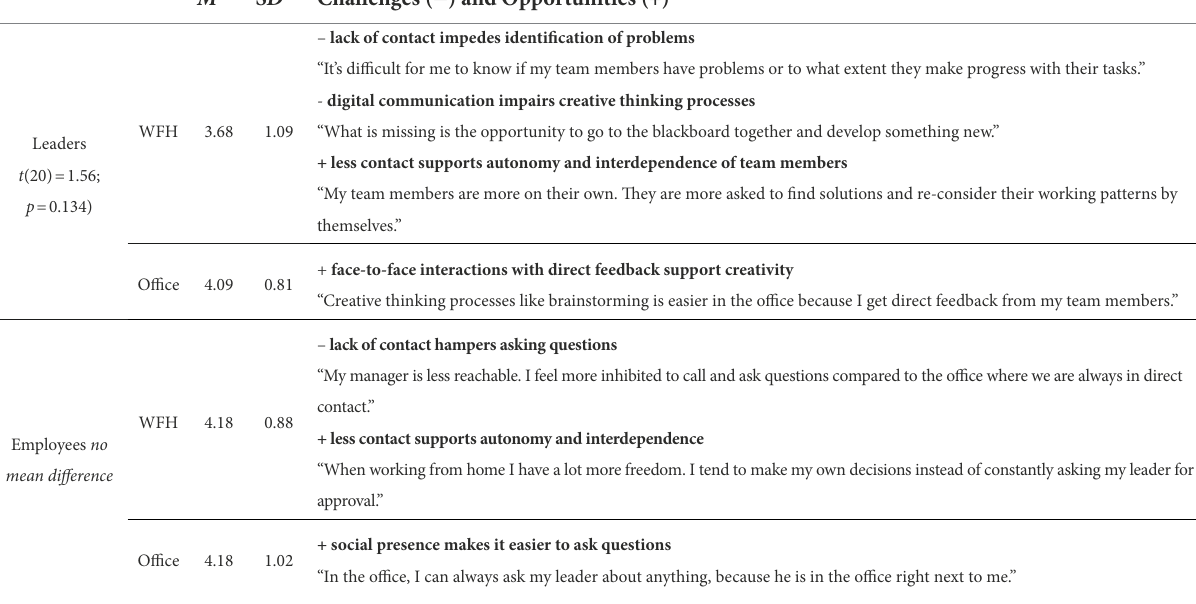
TABLE 3 Challenges and opportunities for intellectual